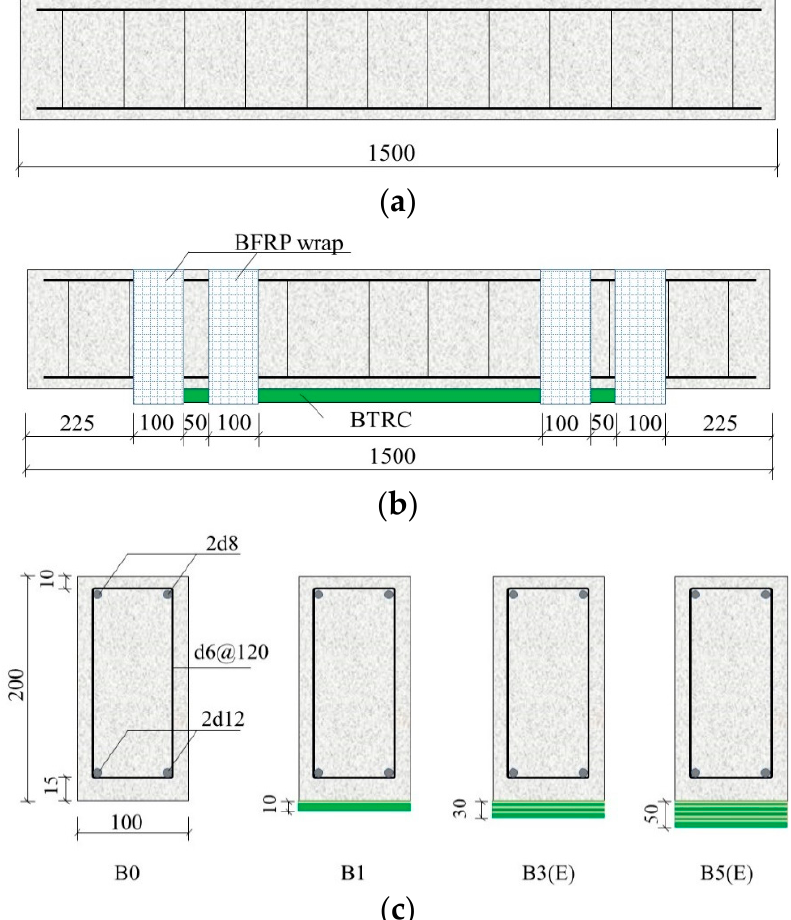
Figure 3. Specimen arrangement for control and strengthened beams. ( a ) Control beam. ( b ) BTRM- strengthened beam. ( c ) Sectional details.